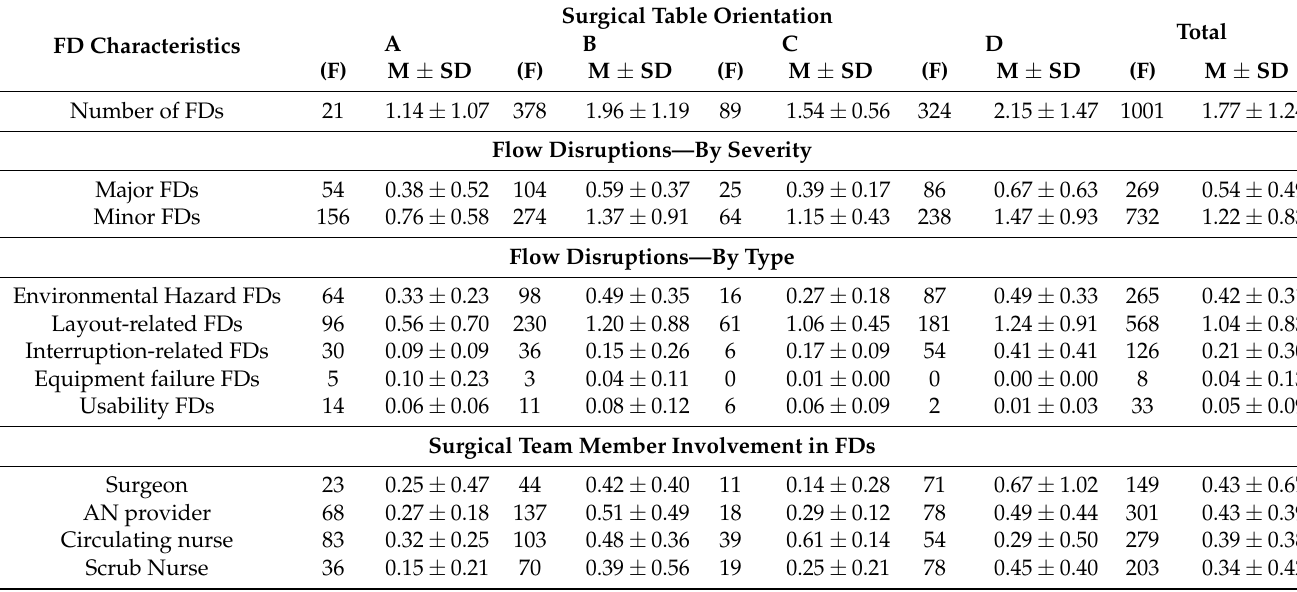
Table 3. Flow disruptions across different surgical table orientations.